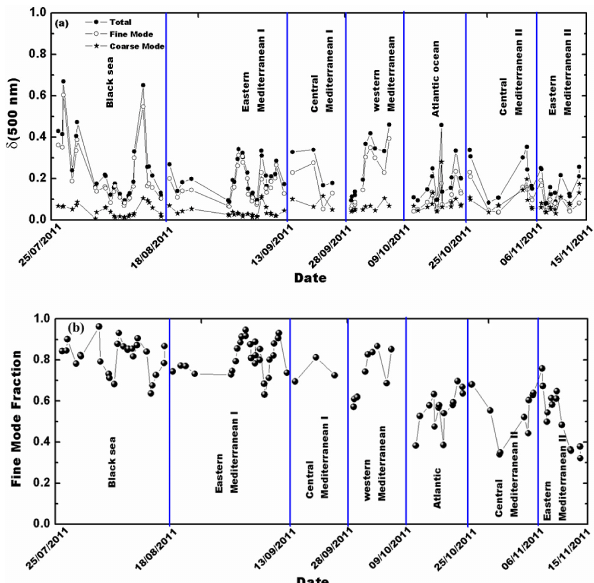
Figure 7. Temporal evolutions of δ a (500nm), δ F (500nm), δ C (500nm), and FMF obtained onboard the Nautilus ship. The data belong to the Maritime Aerosol Network (MAN) and were acquired between 26 July and 13 November